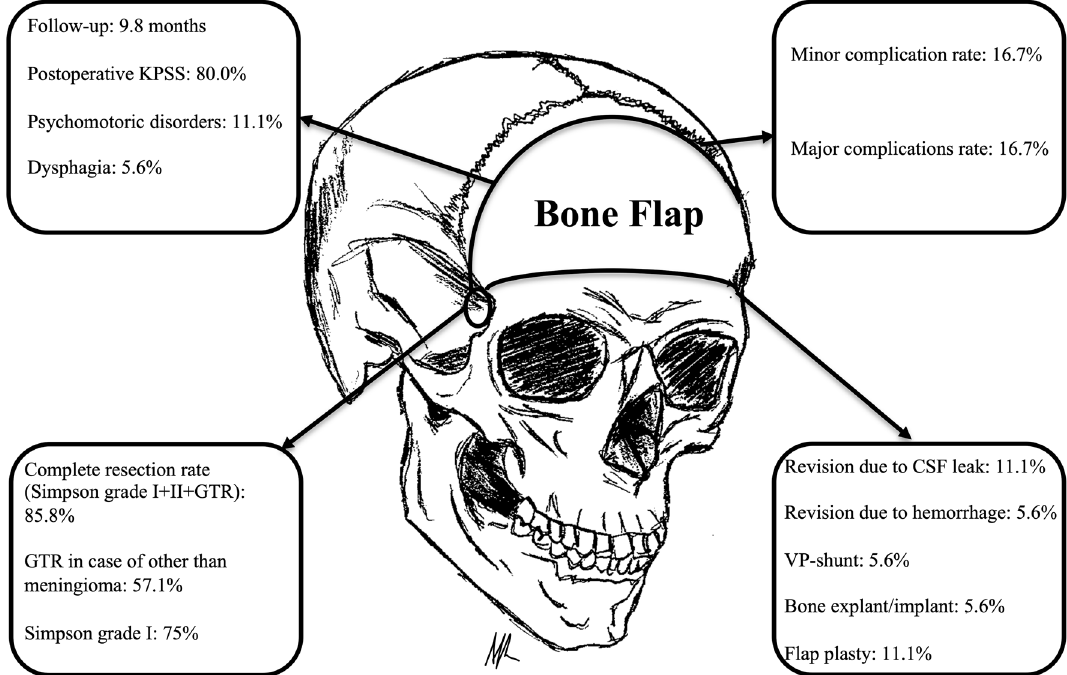
Figure 6. Illustration of classic basal bifrontal craniotomy for transbasal approach, complete resection rates, postoperative outcome and